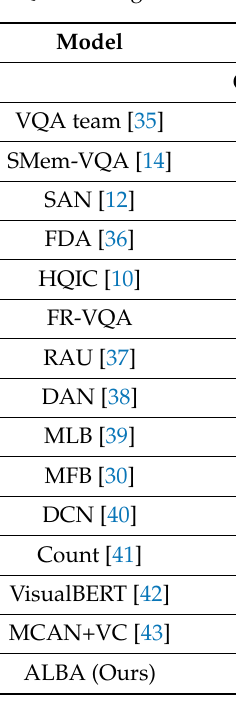
Table 2. Comparison of the results between the proposed method and the other published methods on VQA2.0 using similar